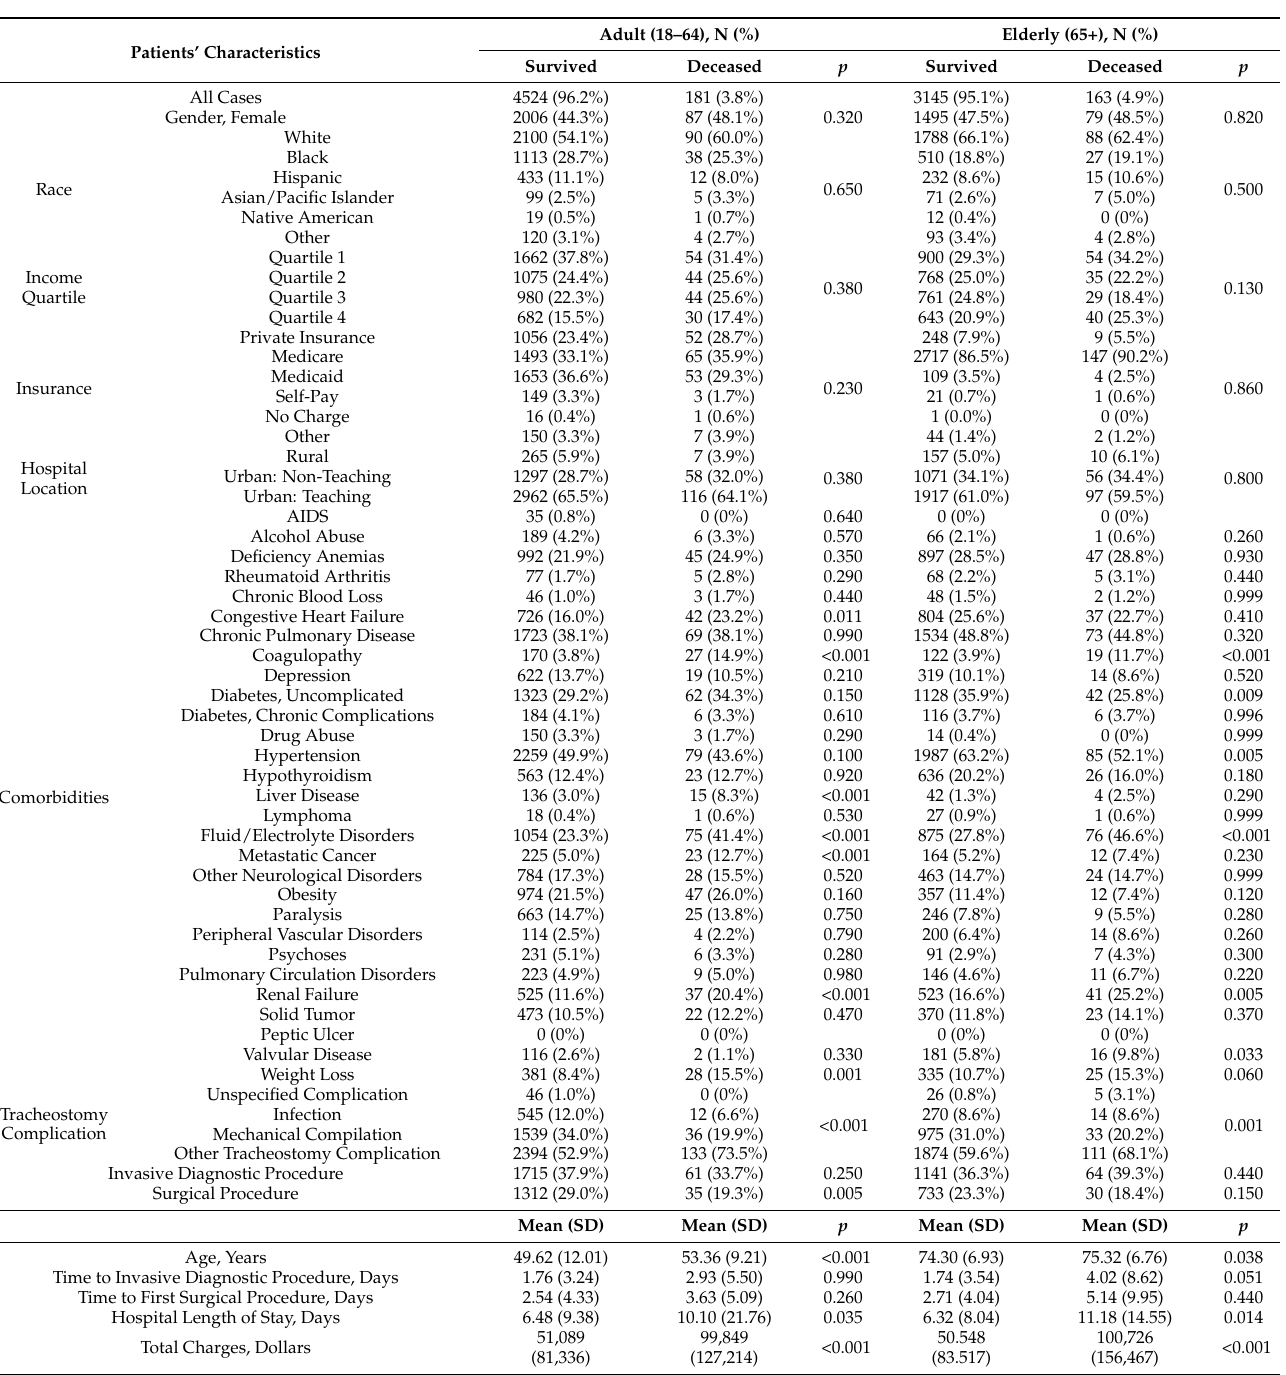
Table 3. Characteristics of emergently admitted patients with the primary diagnosis of tracheostomy complications. Data were classified according to outcome categories, NIS